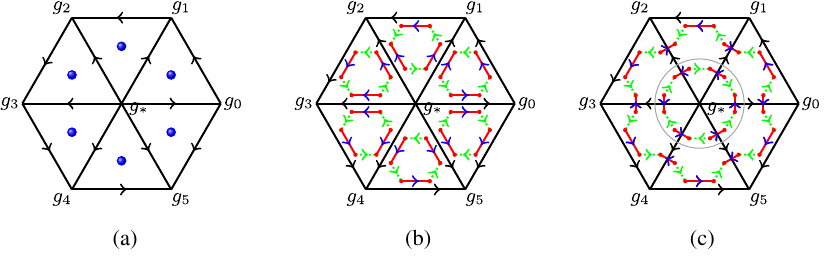
FIG. 5. FSLU transformations for “ FSPT ” state on a 2D surface with boundary. Similar to the “ FSPT ” state on a closed surface, there are two FSLU transformations ð a Þ ⟶ U 1 ð b Þ ⟶ U 2 ð c Þ to trivialize the initial 2D “ FSPT ” state. (a) Original 2D “ FSPT ” state with complex fermion decorations. (b) There is exactly one Kitaev ’ s Majorana chain inside each triangle (red links). (c) There is one Kitaev's Majorana chain around each bulk vertex. The degrees of freedom inside the gray circle are combined to be the new basis state j g the bulk vertex. There is a remaining 1D ASPT state along the 1D boundary of the 2D bulk.